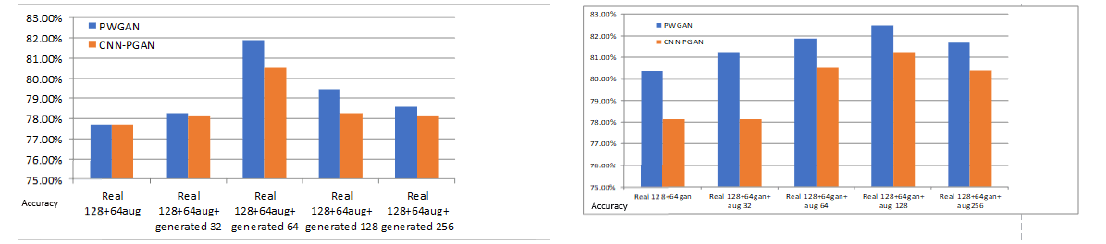
Figure 11. The accuracy for different training datasets. The blue bar and the yellow bar indicate the classification accuracies of PWGAN and CNN-PGAN, respectively. ( a ) The first column is the classification result on the training dataset (128 real images and 64 augmented images). The second, third, fourth, and fifth columns are the results of training data augmentation using 32, 64, 128, and 256 generated images, respectively; ( b ) The first column is the classification result on the training dataset (128 real images and 64 augmented images). The second, third, fourth, and fifth columns are the results of training data augmentation using 32, 64, 128, and 256 augmented images, respectively. The test set is always the